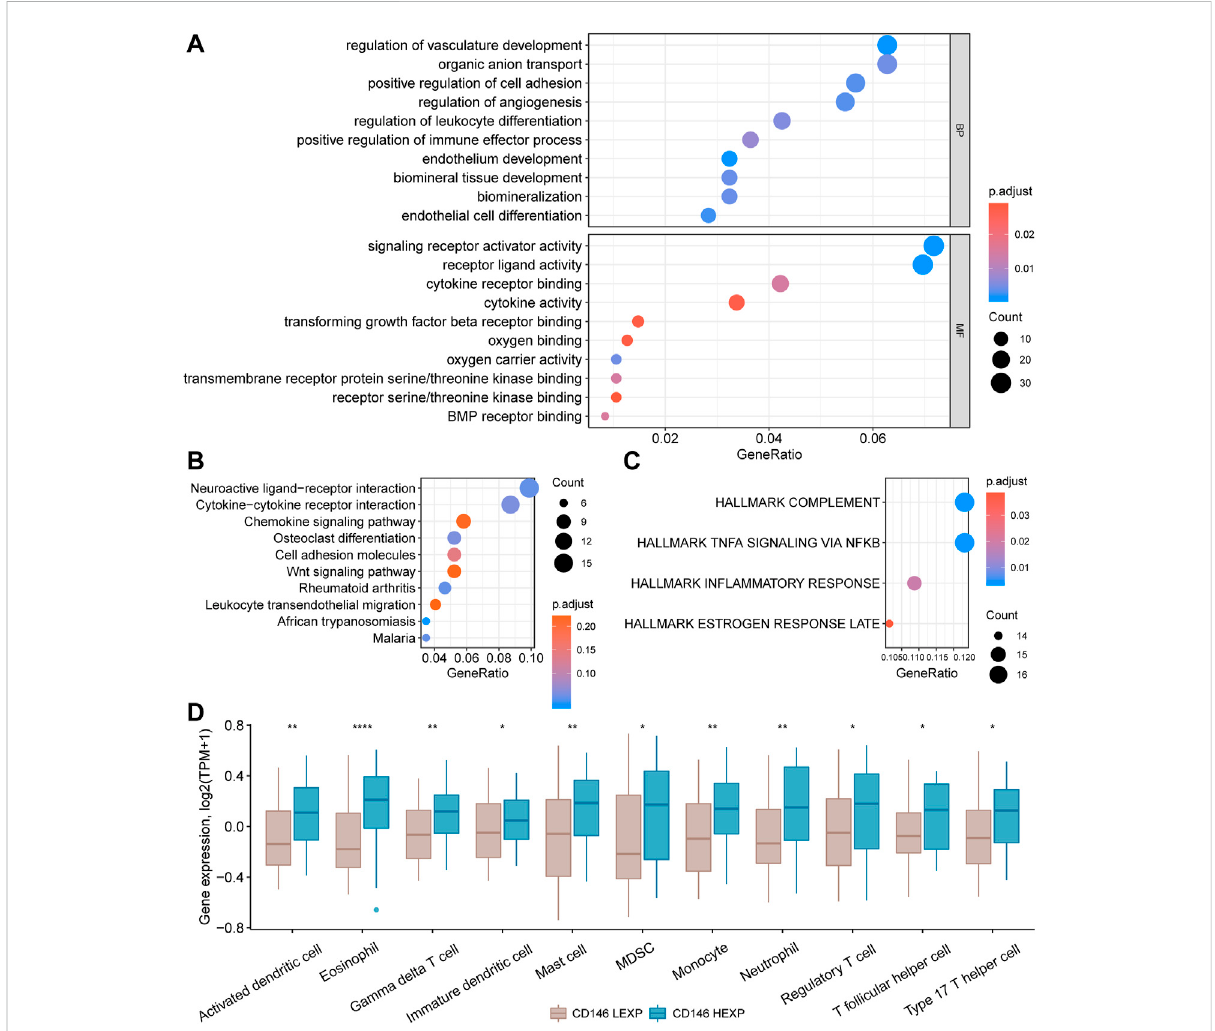
FIGURE 5 Enrichment of signaling pathways and differential in fi ltration of immunocytes in the CD146 high and low groups. Enrichment of 580 DEGs between the HEXP and LEXP subgroups by GO terms (A) , KEGG terms (B), and HALLMARK terms (C) . (D) Differential in fi ltration of 12 immunocytes between the CD146 high and low